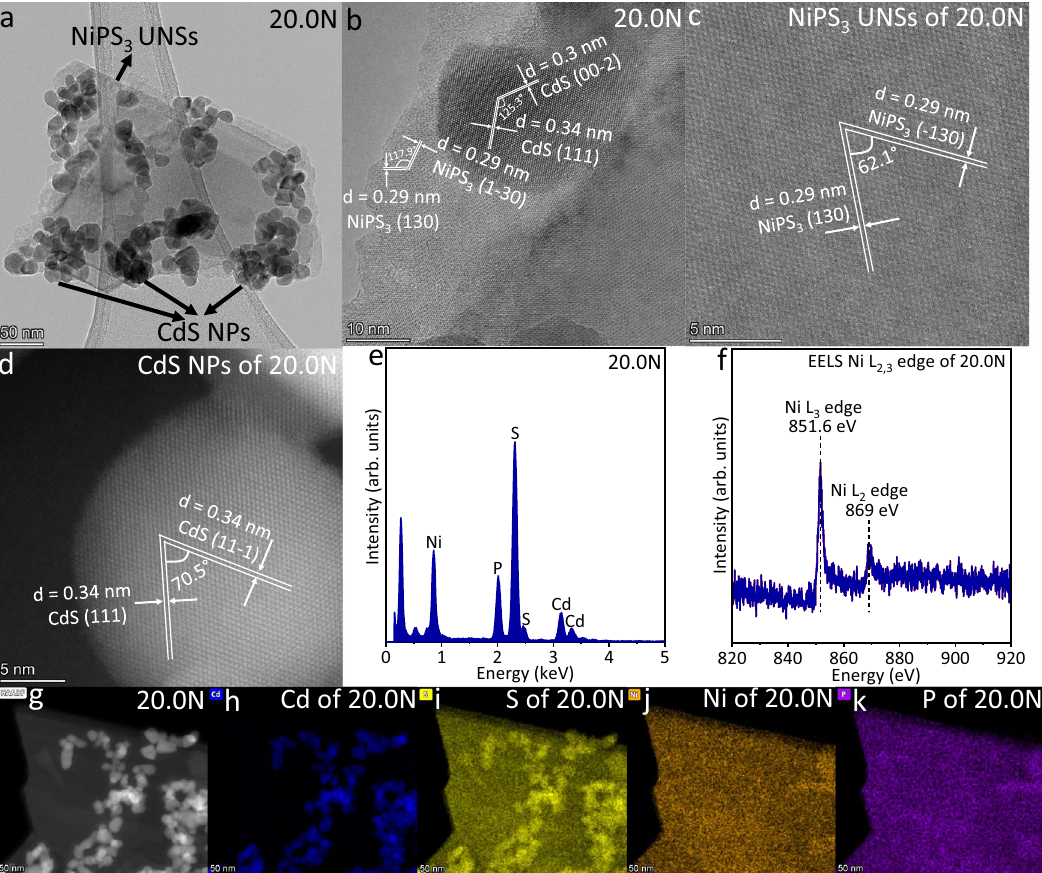
f EELSspectrumofNiL 2,3 edge for20.0N. g HAADF-STEMimage of20.0Nand the corresponding elemental mapping images of h Cd, i S, j Ni and k P elements in